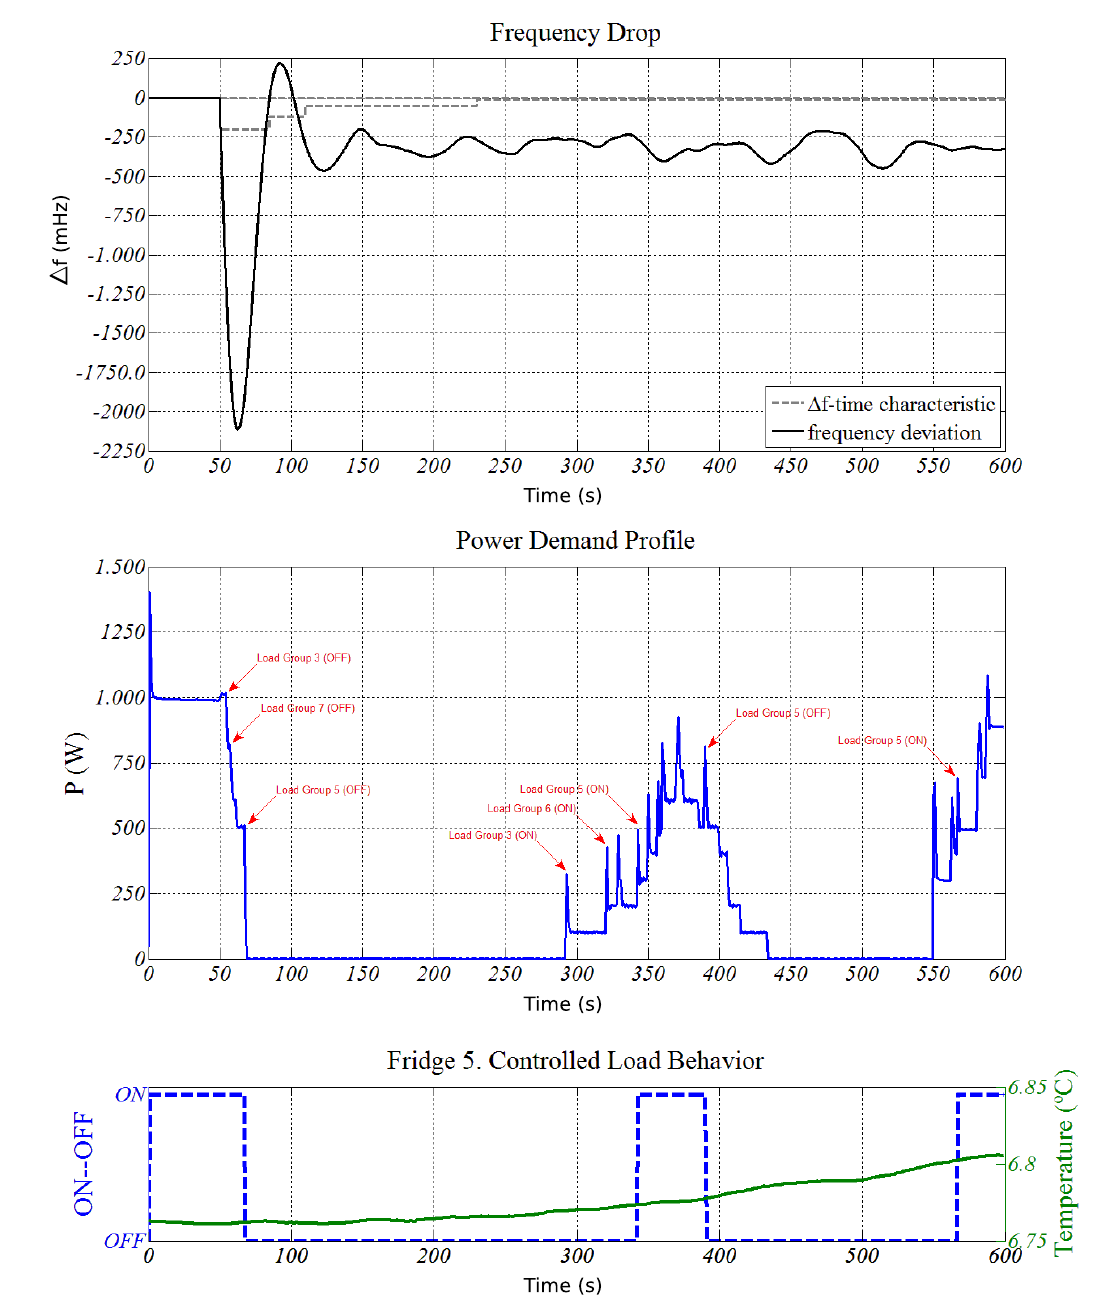
Figure 11. Case Study (I). Aggregate power demand profile and example of fridge temperature